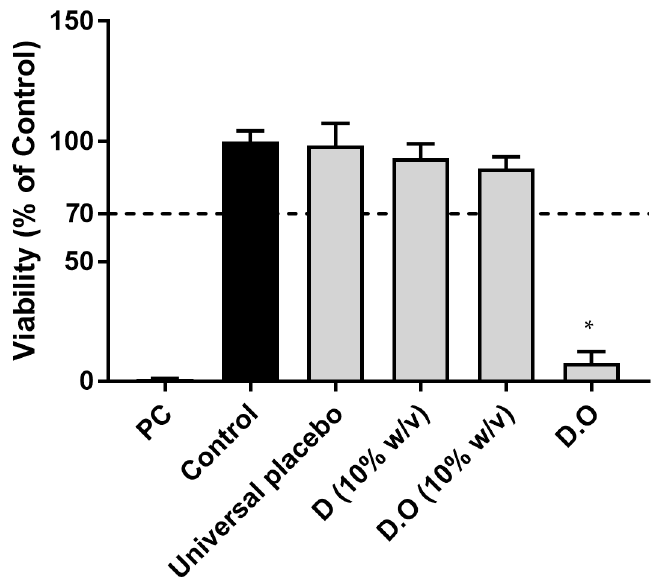
Figure 5. Cellular viability evaluated on Reconstructed Human Vaginal Epithelium model (MTT assay) of vaginal sheet D (10% w/v ), vaginal sheet D with TCEO (10% w/v dissolution), vaginal sheet D with TCEO directly applied and universal placebo. Results are presented as the mean and standard deviation from 3 independent experiments. * represents statistically significant difference from negative control ( p < 0.05).